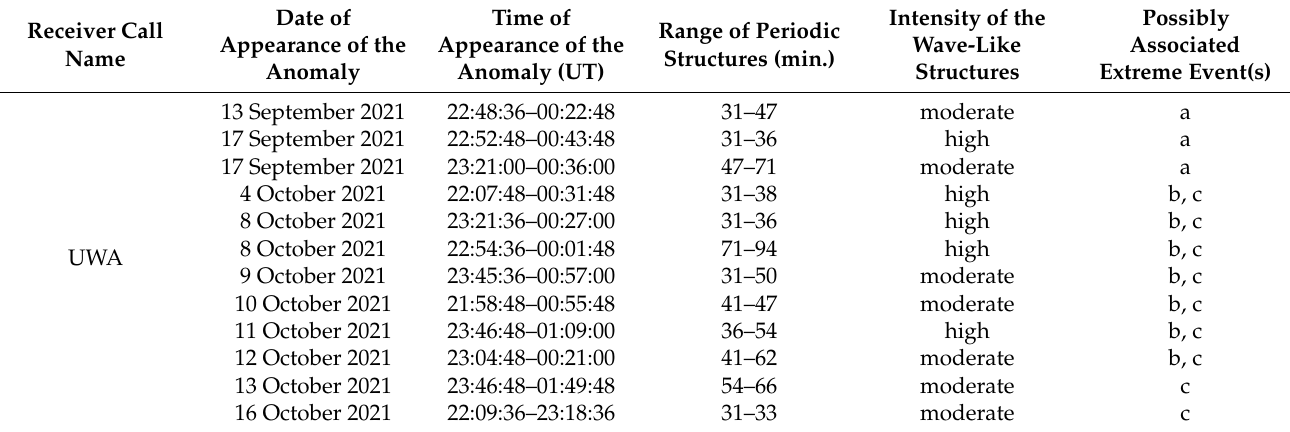
Table 11. Results of wavelet analysis for the 2021 Crete EQs.